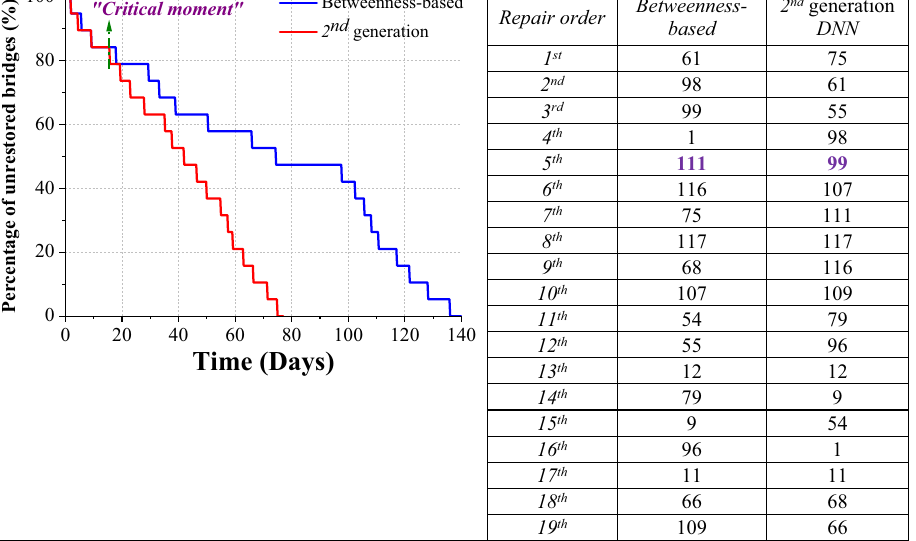
Figure 4. Post-shock rapid response shaped by the learning-based and the baseline strategies. The time-varying quantity of remaining severely-damaged bridges, which are under rapid responses following such two different strategies, are tracked. Especially, the “critical moment”, when the two trajectories bifurcated has also been highlighted.